Question: In one sentence, what is this figure communicating?
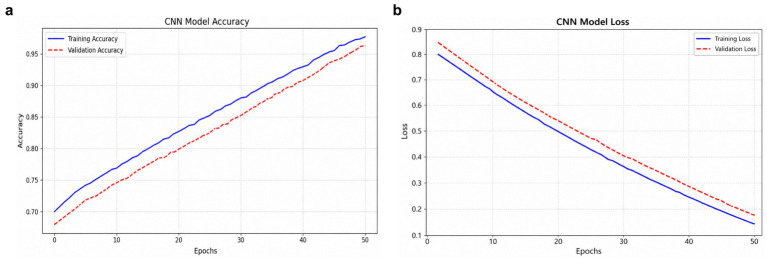
Answer: (A) Training and validation accuracy for the CNN model, showing convergence after 50 epochs. (B) Training and validation loss curves for the CNN model, showing convergence after 50 epochs.